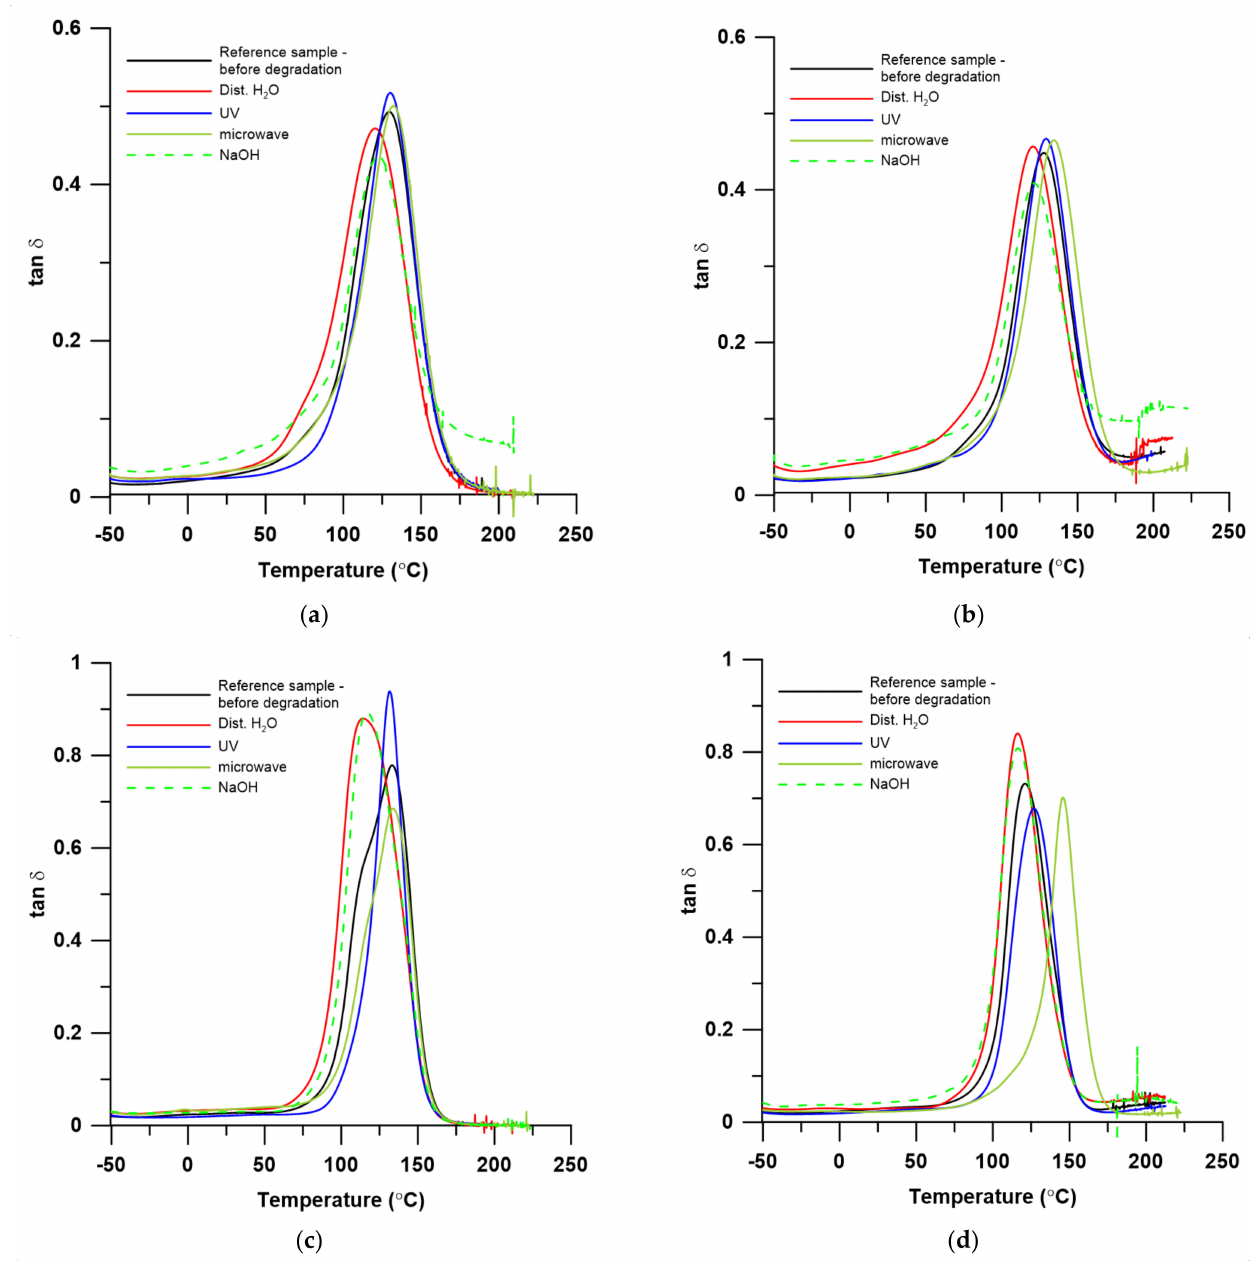
Figure 7. The temperature-dependent graph of damping factor ( tan δ ) before and after degradation: ( a ) pure UPR; ( b ) UPR + L; ( c ) pure VER; ( d ) VER +